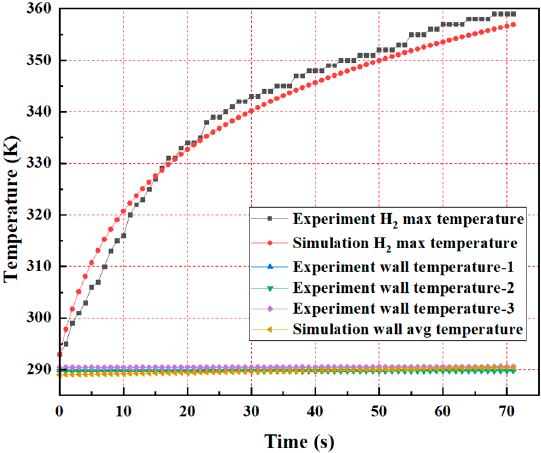
Figure 5. Comparison of the temperature rise between the experiments and simulation results.